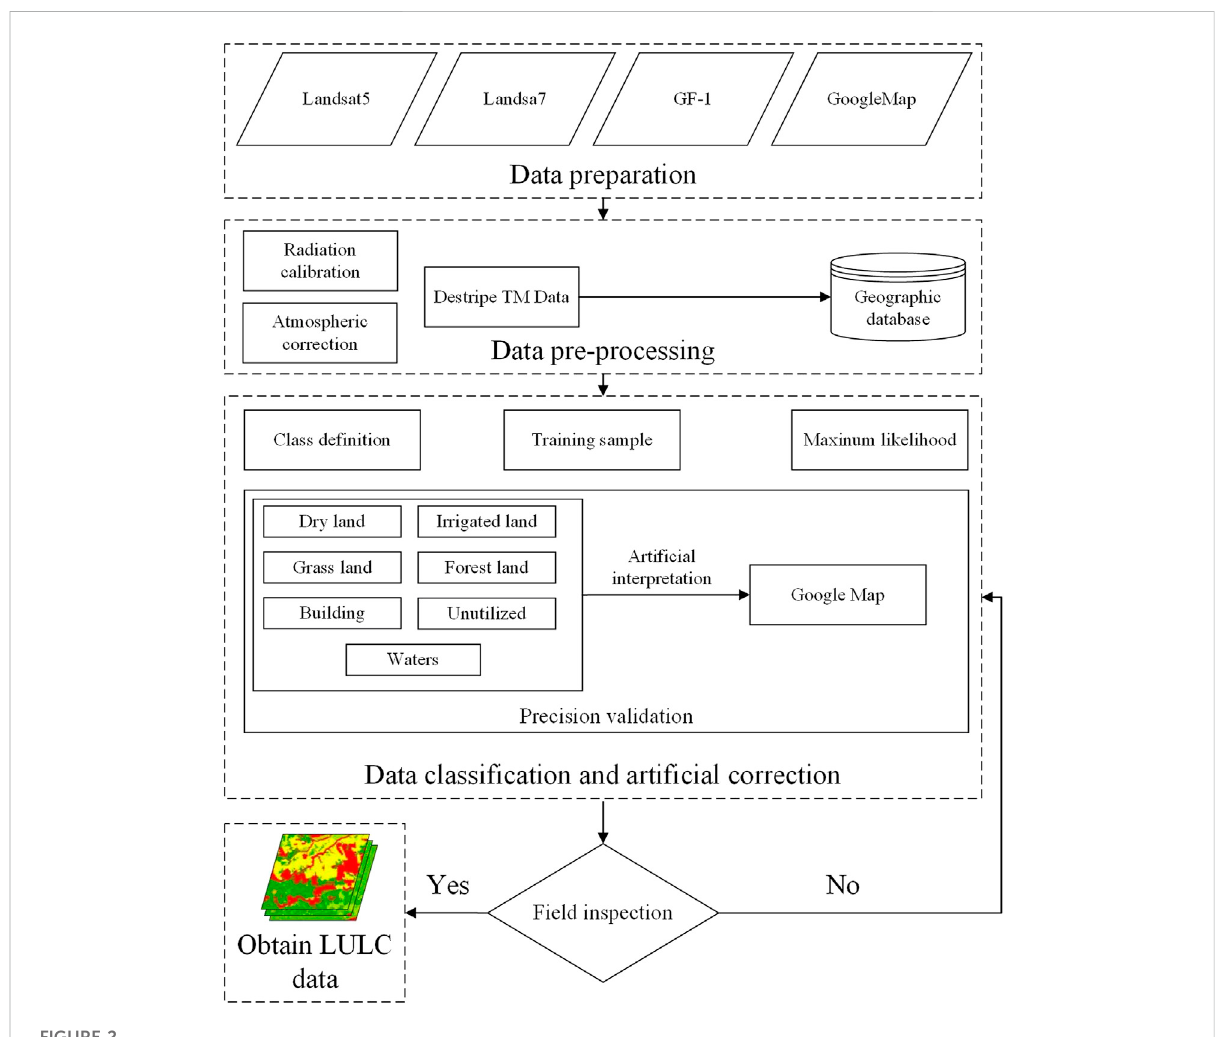
FIGURE 2 Data pre-processing process.